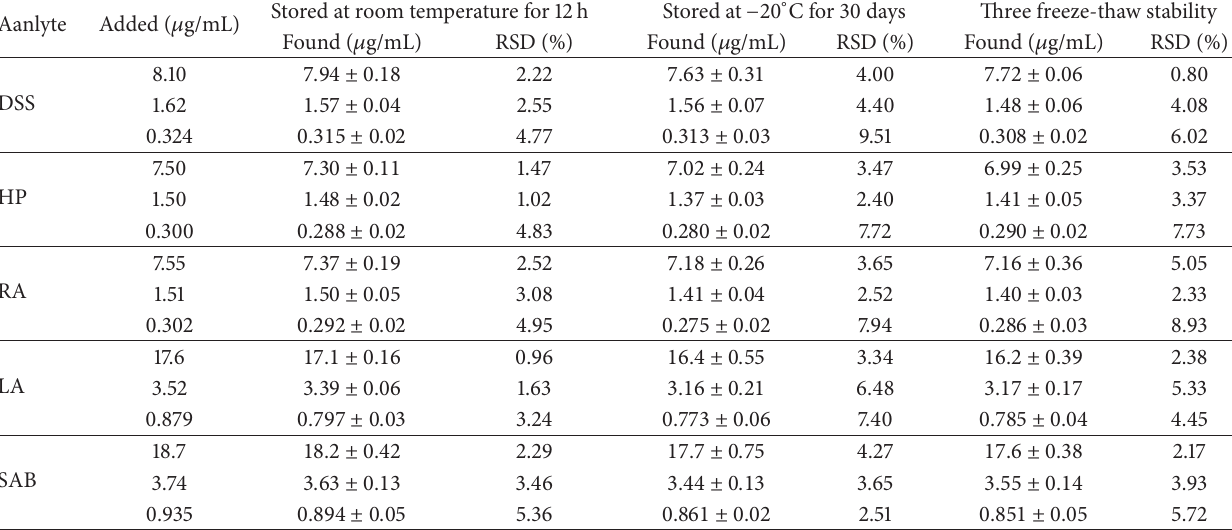
Table 4: Stabilities of SAB, RA, LA, DSS, and HP ( 𝑛 = 3 ). Aanlyte Added ( 𝜇